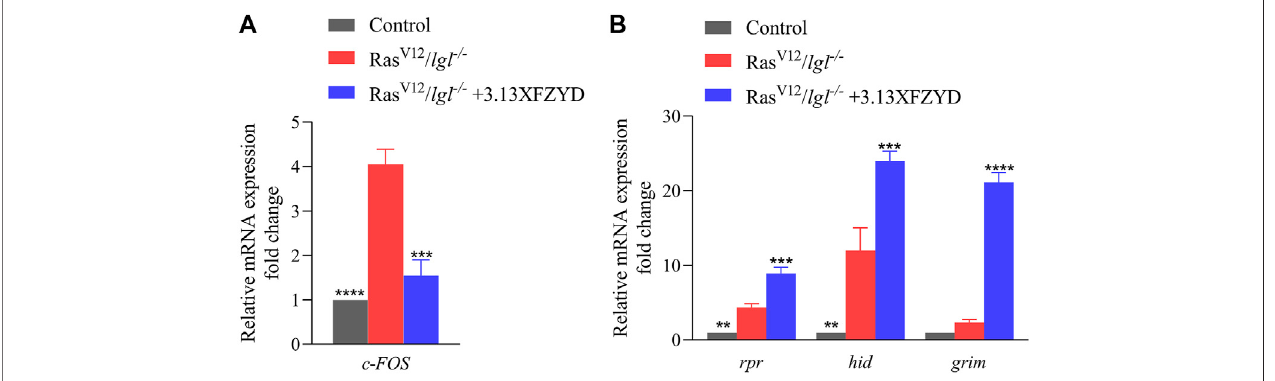
FIGURE8| XFZYDregulatesthetranscriptionof c-FOS ,rpr,hid,andgrim.mRNAlevelsof c-FOS (A) , rpr , hid ,and grim (B) ,asmeasuredbyqRT-PCR( n =3).Error bars represent the standard deviation. One-way ANOVA with Bonferroni ’ s multiple comparison test was used to compute p-values . **** p < 0.0001, *** p < 0.001, ** p <